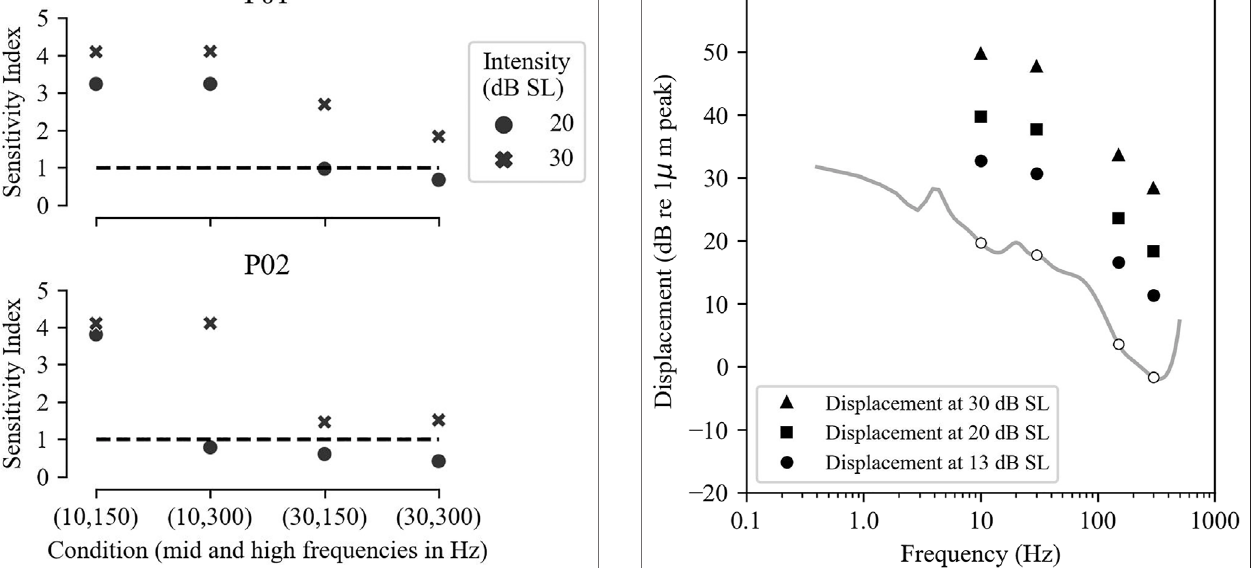
FIGURE 5 | Vibrotactile thresholds on the volar forearm. The solid gray line is re-plotted from Figure 1 of (Bolanowski et al., 1994). The thresholds at 10, 30, 150, and 300 Hz are highlighted by four open circles. Filled circles, squares and triangles denote the displacement values at 13, 20 and 30 dB above threshold, respectively, for the four